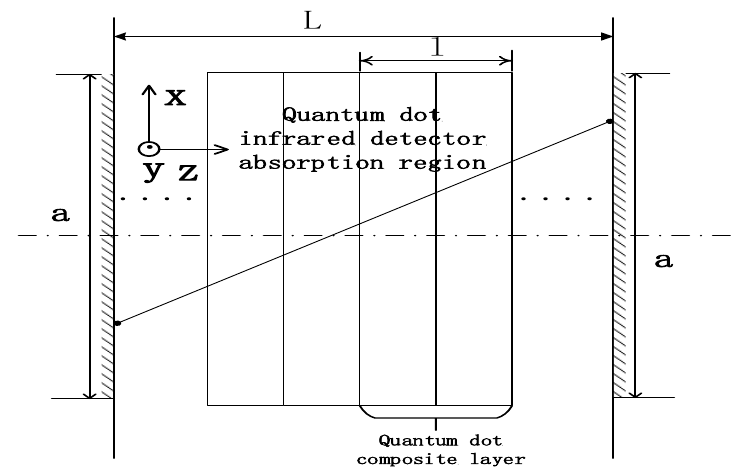
Figure 2. Side schematic diagram of quantum dot photodetector with MSM structure. To be concreted, the left and right metal surfaces are firstly divided into Q , P units along the x and y directions, respectively, so that the corresponding matrices u 1 n and u 2 n are respectively shown